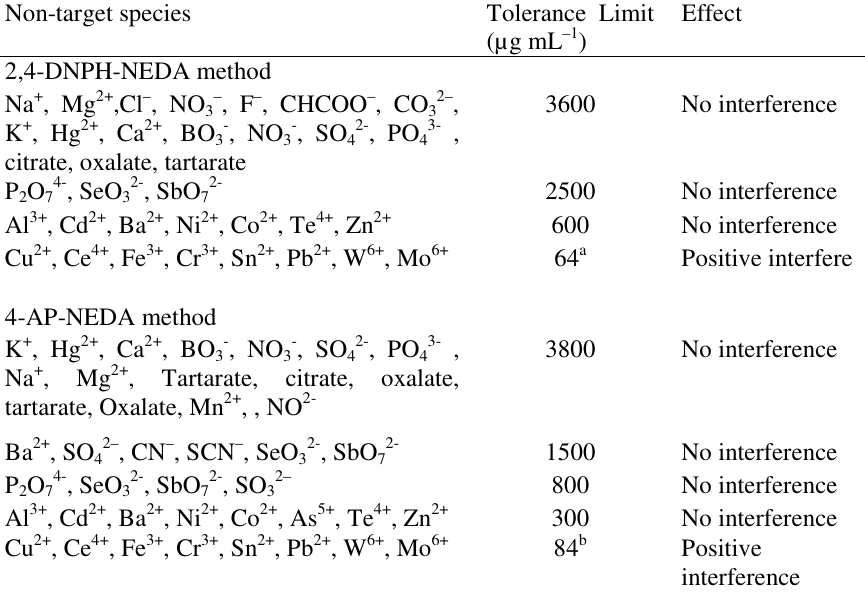
Table 2 . Effect of non-target species in the determination of vanadium (V) 2.5 µg ml –1